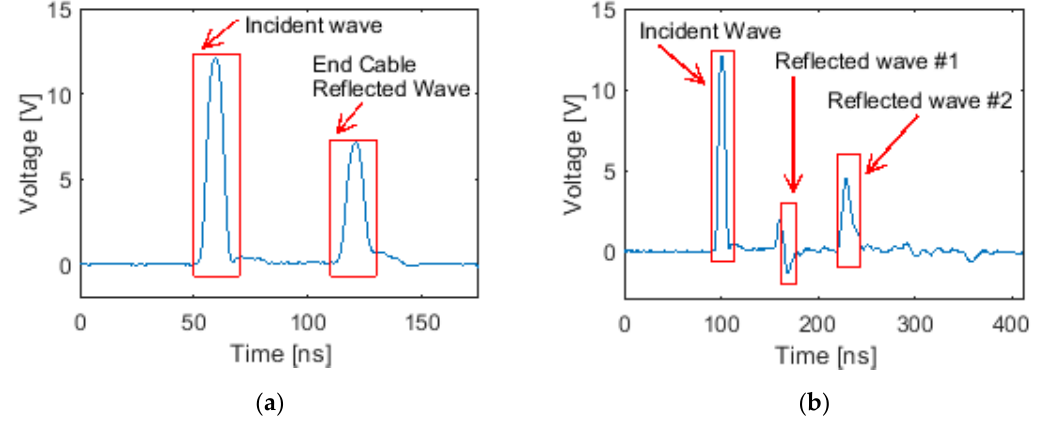
Figure 10. ( a ) ETDR testing of an RG-6 coaxial cable transmission line in open-circuit mode was performed to determine the pulse speed. ( b ) ETDR tests with a single capacitive tilt sensor was performed, and a representative voltage-time history response is plotted. The reflected waves are marked accordingly in each plot.